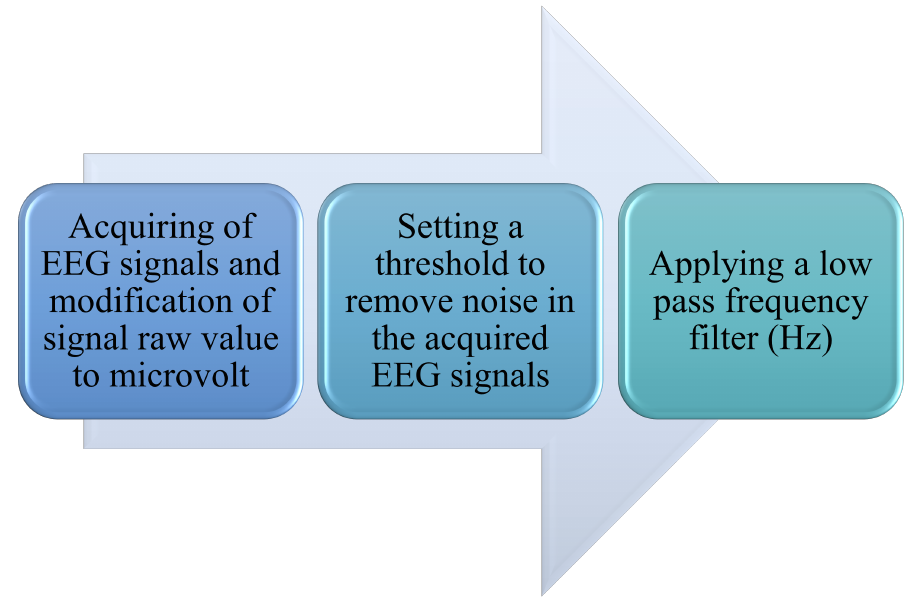
Figure 8. Flowchart of EEG signal pre-processing.